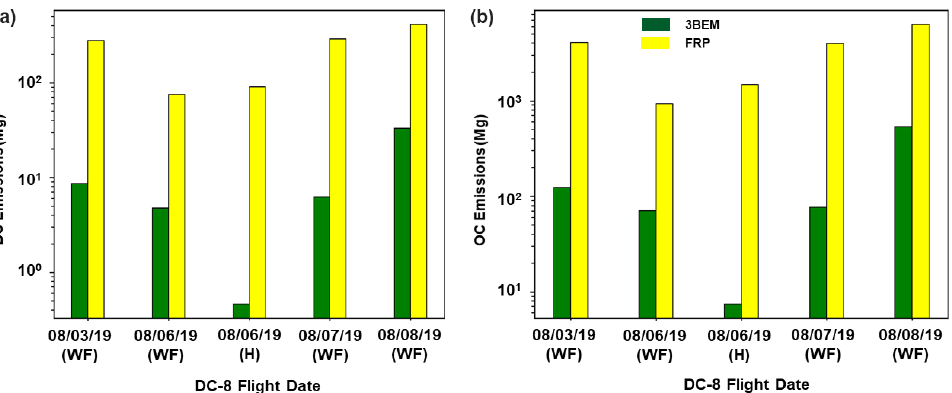
Figure 4. Model-predicted BC (a) and OC (b) emissions from the Williams Flats (WF) fire on the DC-8 science flight days (3–8 August 2019) during FIREX-AQ. The emissions for Horsefly (H) fire on 6 August 2019 are also included (bar set 3 for BC and